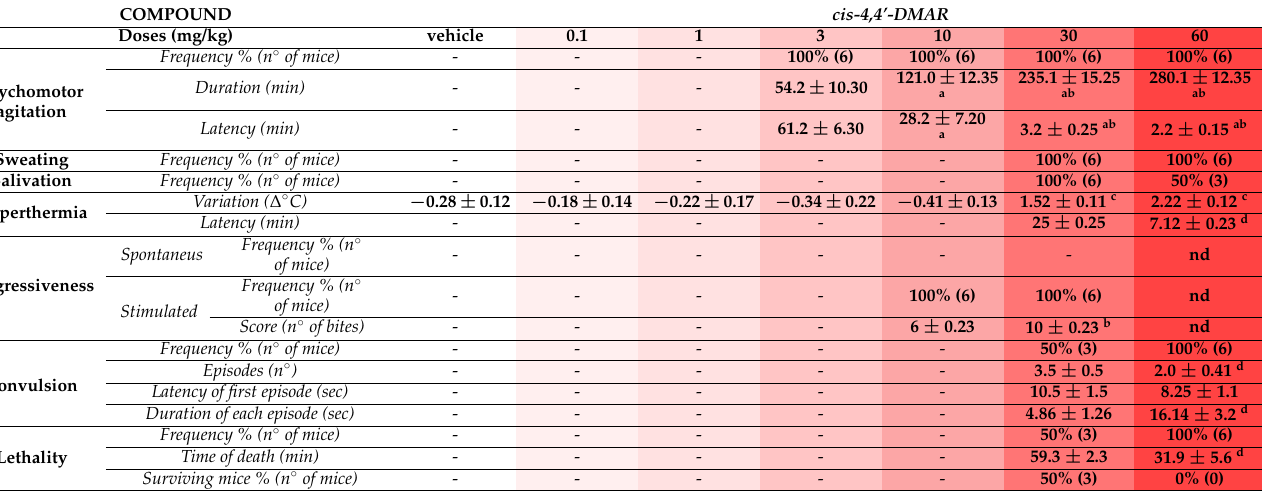
Table 1. Effect of ( ± ) cis -4,4 (cid:48) -DMAR (0.1–60 mg/kg i.p.) on neuro-behavioural changes (psychomotor agitation, aggres- siveness, convulsions), physiological alterations (sweating, salivation, hyperthermia) and lethality in mice. The data here shown (see material and methods) refers to the mean ± SEM values relating to six animals for each treatment. The statistical analysis of the effects of the ( ± ) cis -4,4 (cid:48) -DMAR in different concentrations were performed using a one-way ANOVA, followed by a Bonferroni test for multiple comparisons. A Student’s t-test was used to determine statistical significance ( p < 0.05) between the two groups. a p < 0.05, versus cis 3 mg/kg; b p < 0.05, versus cis 10 mg/kg; c p < 0.05, versus vehicle; d p < 0.05, versus cis 30